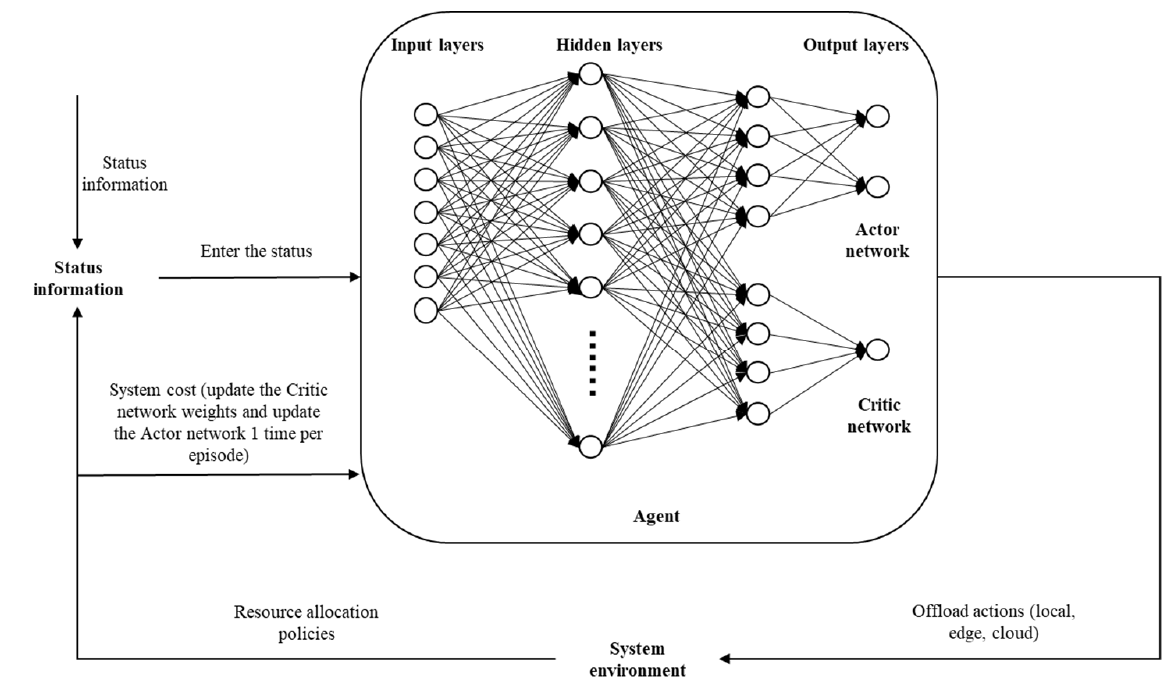
Figure 3. Advantage actor-critic network structure.